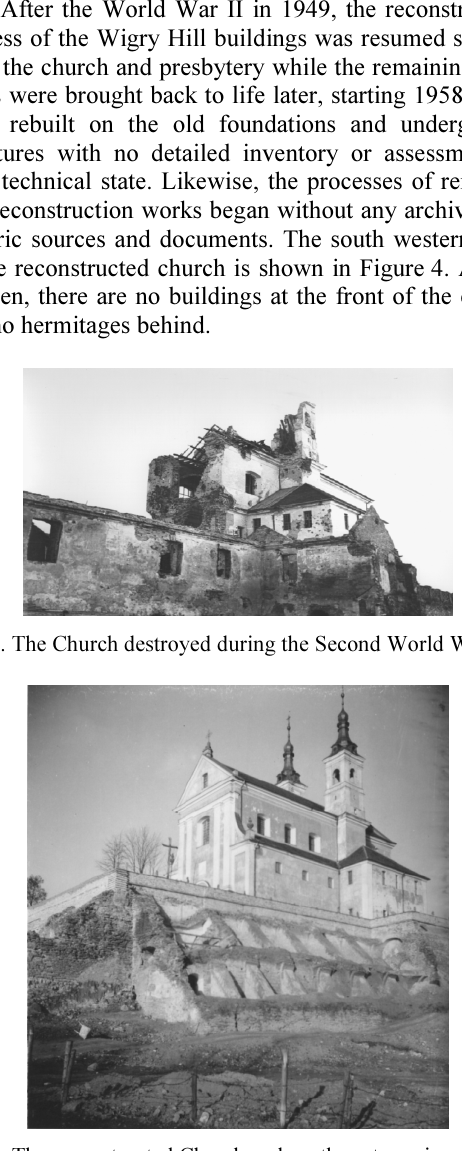
Fig. 4. The reconstructed Church and southwestern view of the retaining walls in 1967